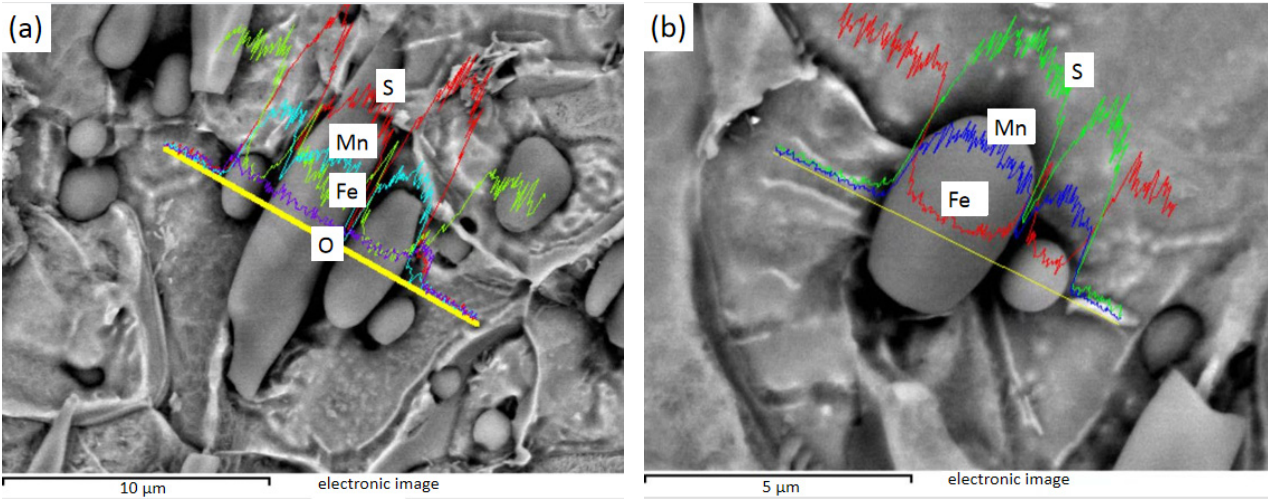
Figure 8. 1# Spherical, fusiform, and rod-bar MnS inclusions: ( a ) spherical, fusiform, and rod-bar MnS; ( b ) spherical and fusiform MnS.